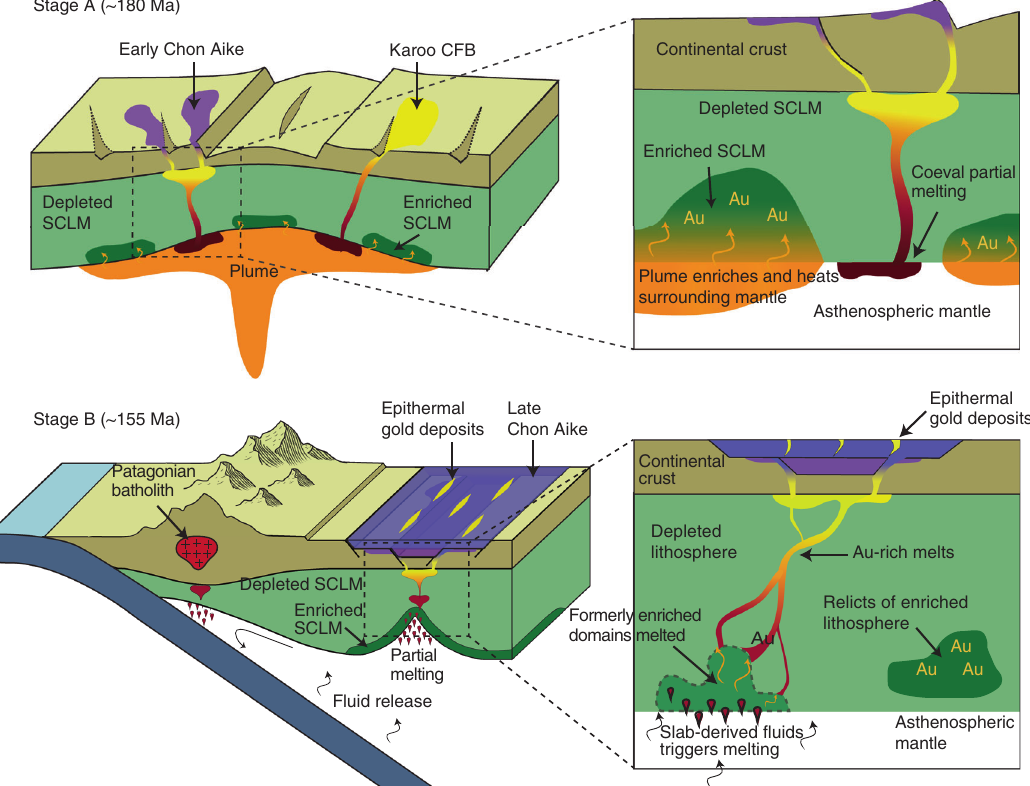
Fig. 3 Lithospheric-scale processes involved in the precursor stage of formation of the Deseado Massif auriferous province. Stage A: plume activity during Early Jurassic related to the initial stages of Gondwana break-up induces metasomatic Au enrichment in the overlying SCLM and coeval partial melting. The inset shows the transfer of Au to the enriched domains and partial melting processes responsible for the early magmatic stages of the CA-SLIP. Stage B: onset of the subduction zone at the western margin of Gondwana provides fl uids capable of scavenging Au from formerly enriched domains and generates calc-alkaline magmatism represented by the middle-late magmatic stages of the CA-SLIP that hosts the Au deposits. The inset shows the process of partial melting of enriched domains and Au transport to crustal levels; some portions of enriched lithosphere remain unmodi fi